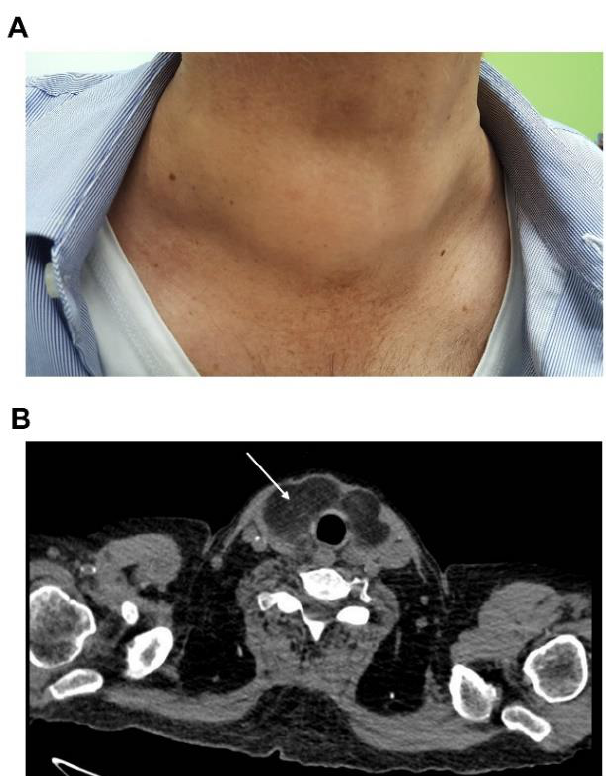
Figure 5. Greasy infiltration of goiter on computerized tomography. ( A ) Clinical goiter of patient C. ( B ) Cross-sectional image on TDM of patient’s C goiter showing greasy infiltration of the thyroid gland characterized by hypodense tissue (white arrow).